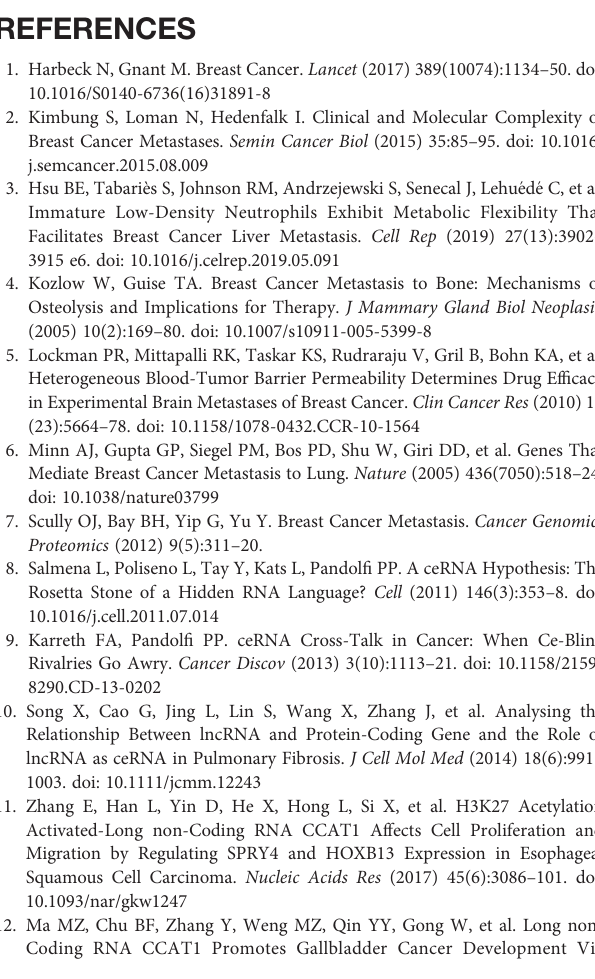
Supplementary Figure 2 | Biological function of differentially expressed and metastasis associated lncRNAs. Supplementary Table 1 | Differentially expressed mRNAs between breast cancer patients and noncancerous tissue samples. Supplementary Table 2 | Differentially expressed miRNAs between breast cancer patients and noncancerous tissue samples. Supplementary Table 3 | Differentially expressed lncRNAs between breast cancer patients and noncancerous tissue samples. Supplementary Table 4 | Differentially expressed mRNAs between M0 and M1 samples.